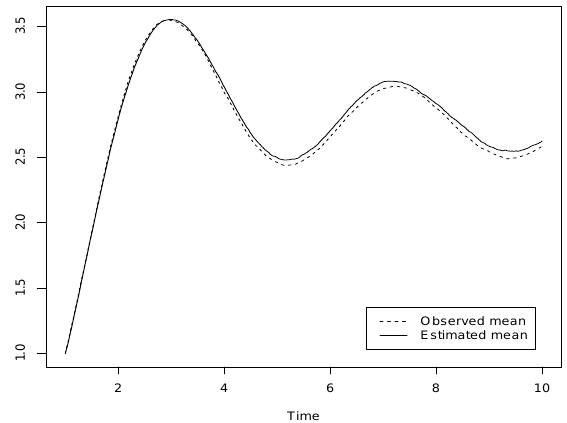
Figure 3. Simulated and estimated mean functions. Gaussian oscillabolastic